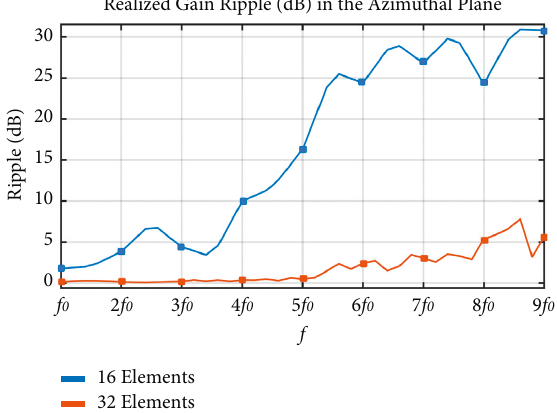
Figure 2: Realized gain ripple in the azimuthal plane at different frequencies for 16 and 32 elements arrays. The array radius has been kept fixed to 0.58 λ max .